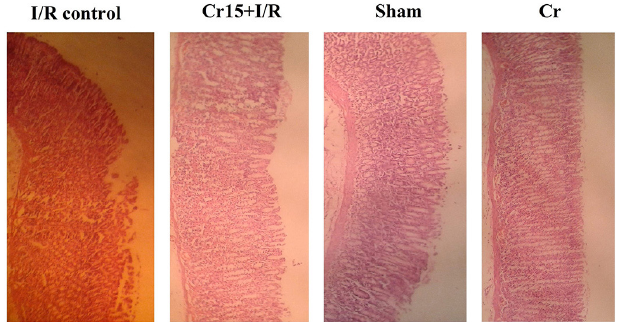
FIGURE 1 - Histological evaluation of the gastric mucosa. Representative gastric sections were obtained 3.5 h after I/R injury. Crocin alone (Cr) and sham-operated groups depict no disruption in the surface epithelium. The I/R injury animals show multiple erosions (A-B), exfoliation and necrosis of superficial cells (arrow shows necrosis in Figure 1A), hemorrhage in the mucosal layer (arrows show hemorrhage in Figure 1B) and severe alterations in the architecture of glandular parts of the gastric mucosa. Cr15+I/R: rats pretreated with crocin (15 mg/ kg 30 min before intervention) demonstrate mild disruption of the surface epithelium. All sections stained with hematoxylin and eosin; ×100